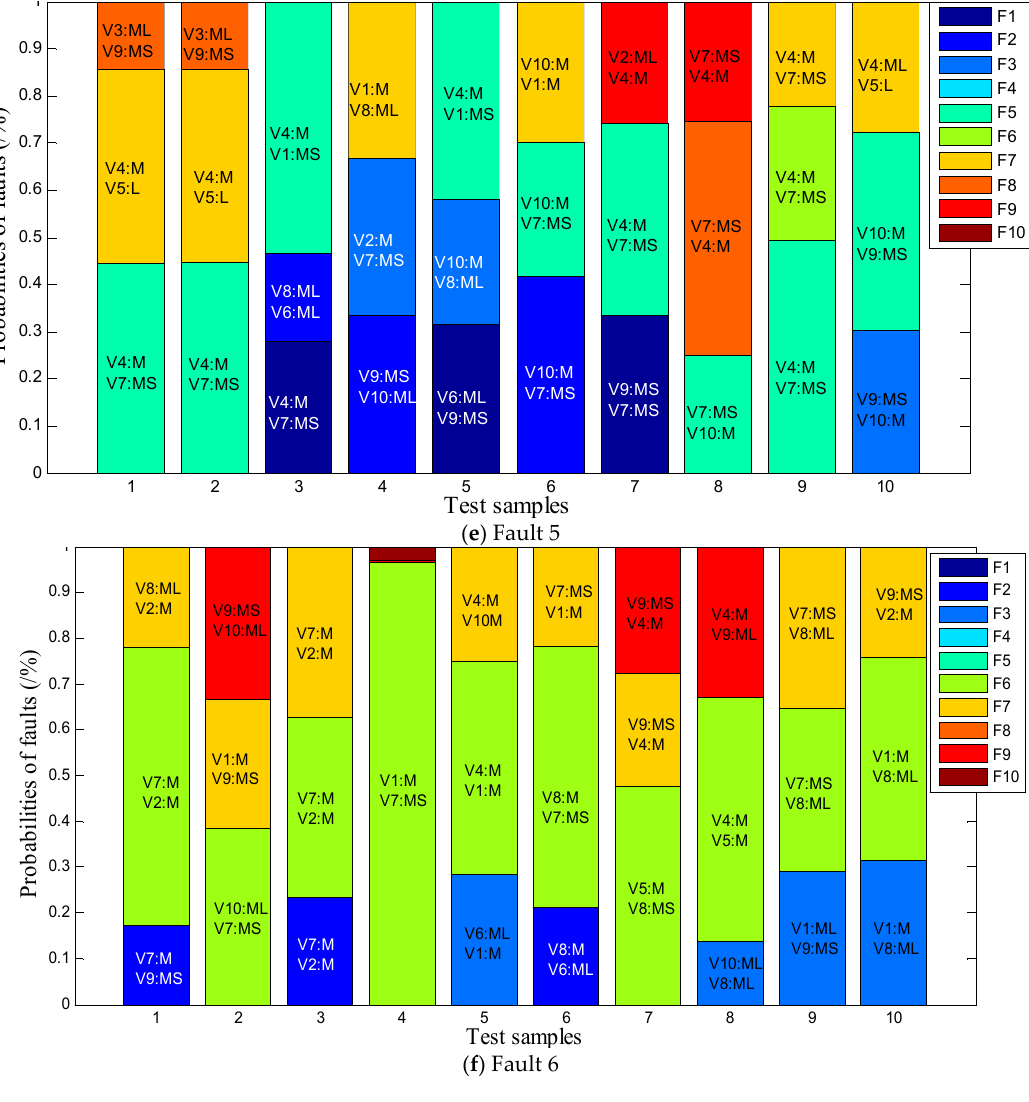
Figure 8. Probability analysis of the sensor faults in offshore WTs.